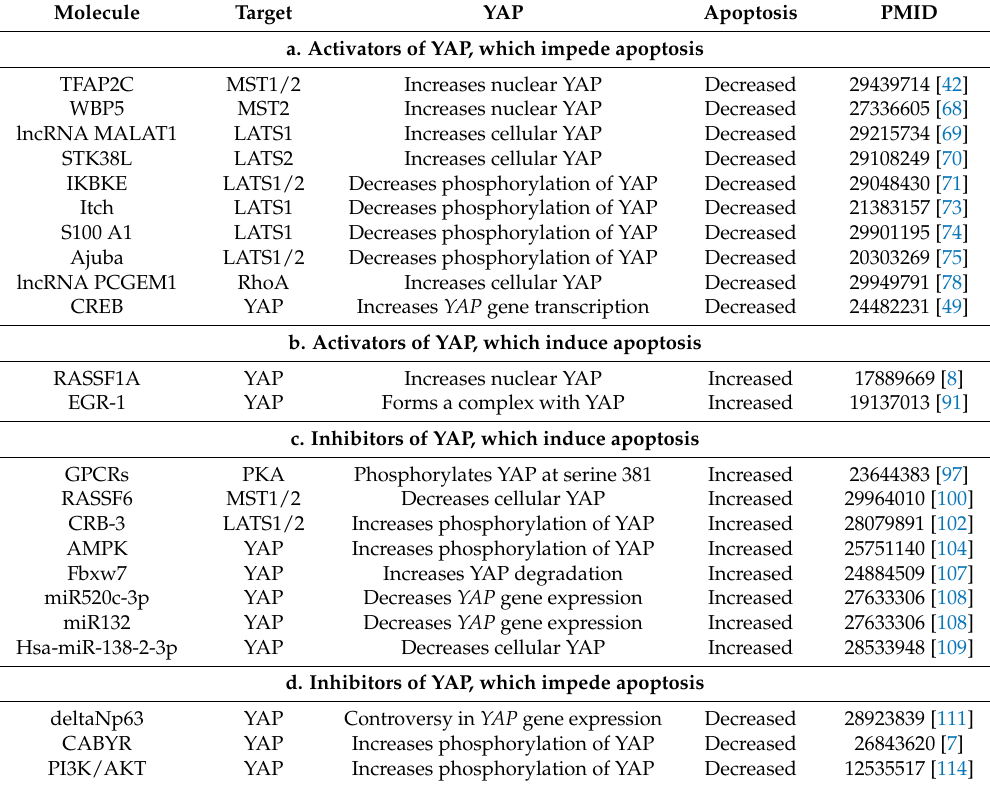
Table 2. Molecules regulate Hippo-YAP signaling and